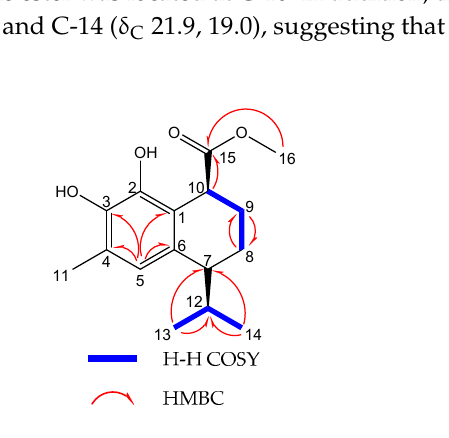
Table 2. In vitro cytotoxicity of dryofraterpene A against five cancer cell lines *.